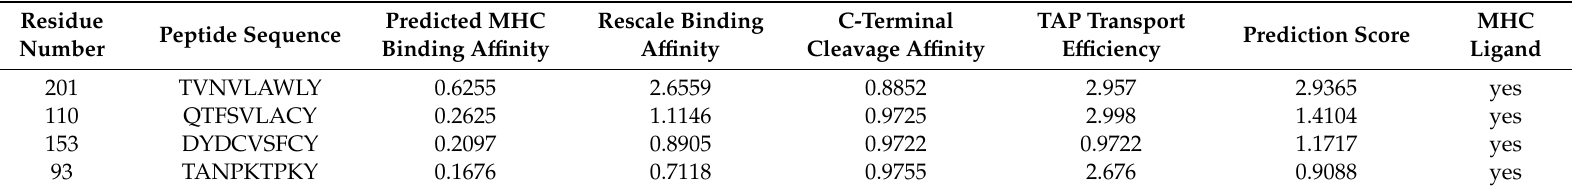
Table 6. CTL prediction from SARS-CoV-2 Main protease *.